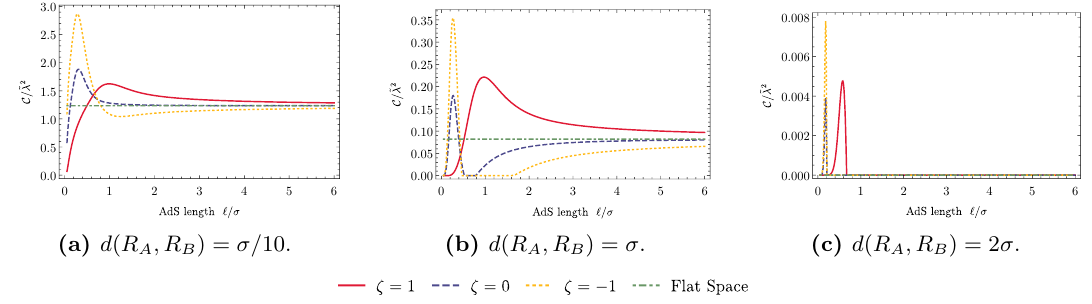
Figure 13 . The concurrence C = ~ (cid:21) 2 associated with the state (cid:26) AB describing detector A located at the origin and detector B on a circular geodesic orbit around the origin is plotted as a function of the AdS length ‘=(cid:27) for di(cid:11)erent values of the detectors proper separation d ( R A ; R B ) =(cid:27) . The energy gap of the detectors is (cid:10) (cid:27) = 1 =